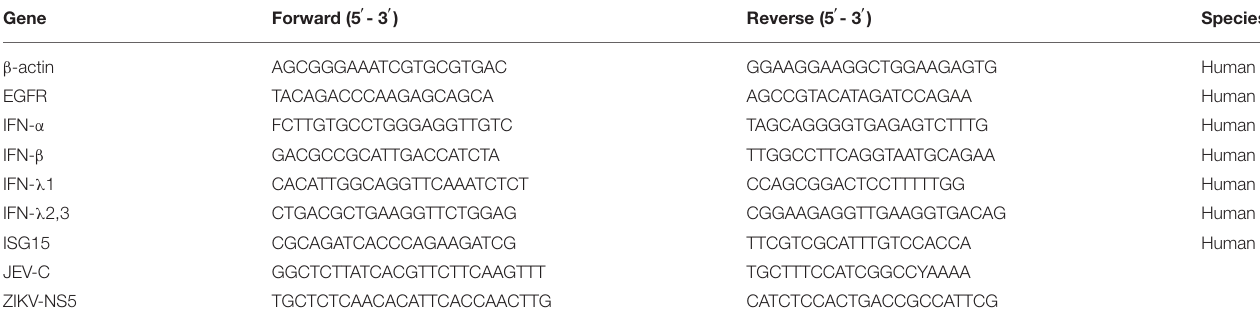
TABLE 1 | Primers used for qPCR in this study.